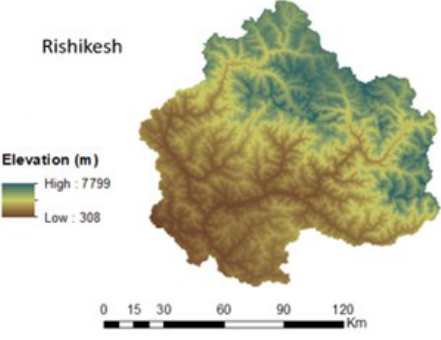
Figure 10. Graphical representation of sub-basin